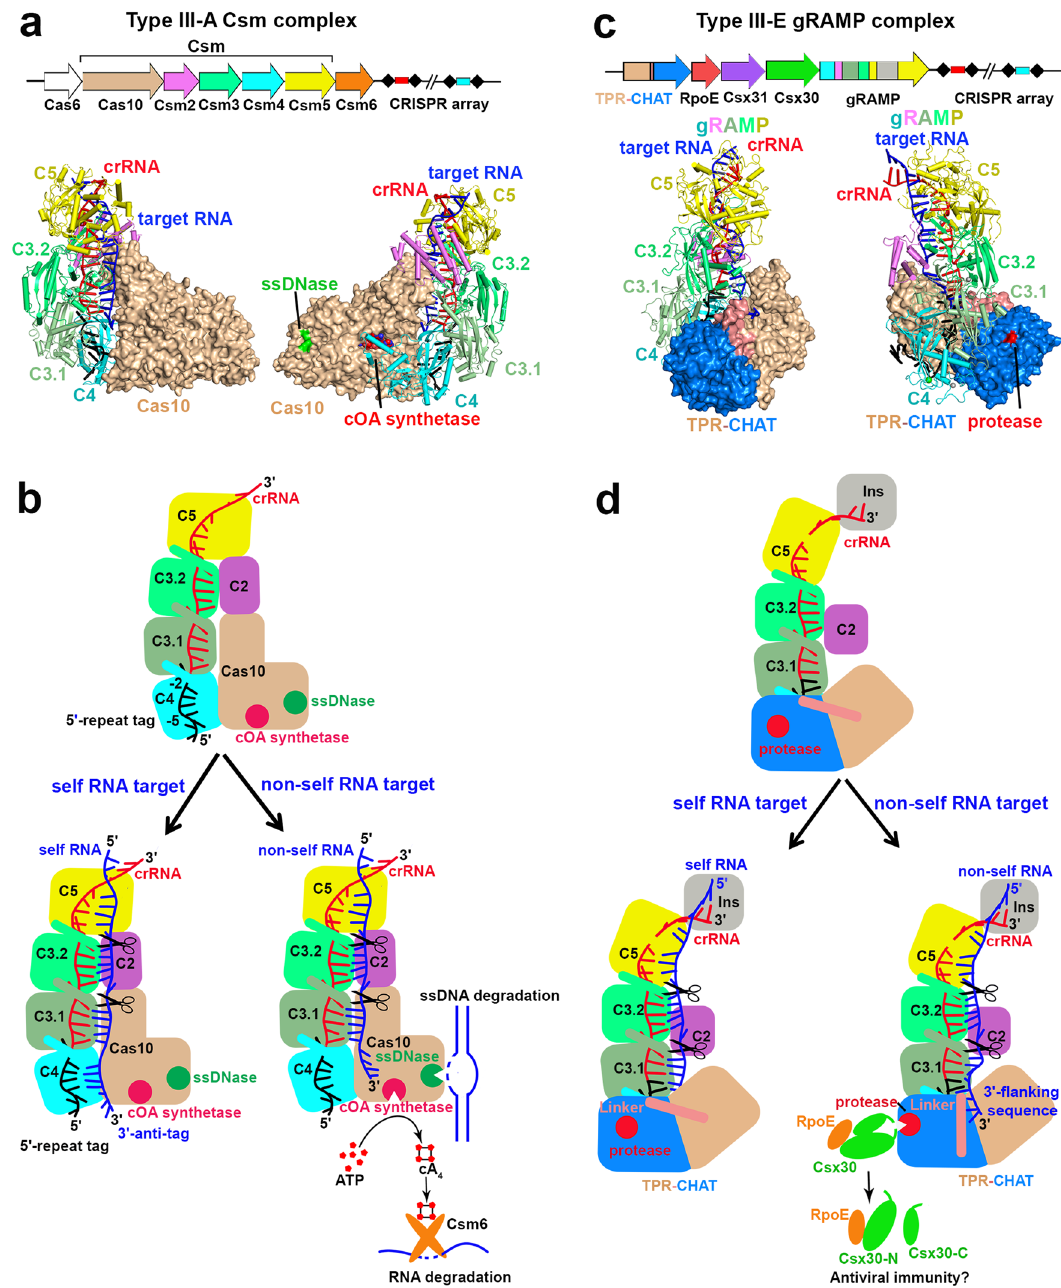
Fig. 6 | Structural and mechanistic comparisons between type III-A and type III-Eeffectorcomplexes. OverallarchitectureofthetypeIII-A(PDB6MUR)( a )and III-E( c )effectorcomplexandCRISPR-loci. b ModeloftypeIII-Ainterferenceduring the immune defense. The type III-A muti-subunit effector complex recognizes the invasive non-selfRNA targets with 3 ′ - fl anking sequencenoncomplementary to the 5 ′ -repeat tag, triggering the non-speci fi c ssDNA cleavage and cOA synthesis by Cas10 protein. The produced cOA activates the Csm6 RNase activity, which is crucialfortypeIII-A immunity.The Cas10enzymicactivities are switchedoffupon the subsequent target RNA cleavage by Csm3 subunits. Binding of the self RNA containing an 3 ′ -anti-tag sequence complementary to the 5 ′ -repeat tag of crRNA could not activate Cas10 activities, but still could be cleaved by Csm3 subunits.